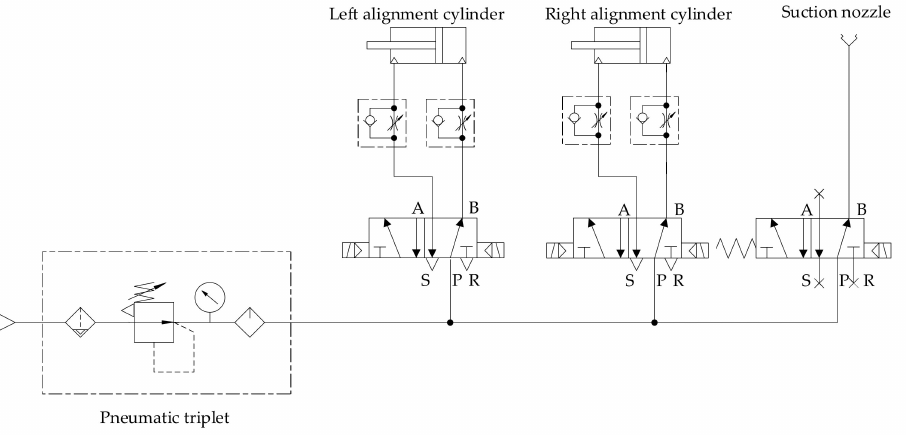
Figure 11. Pneumatic circuit